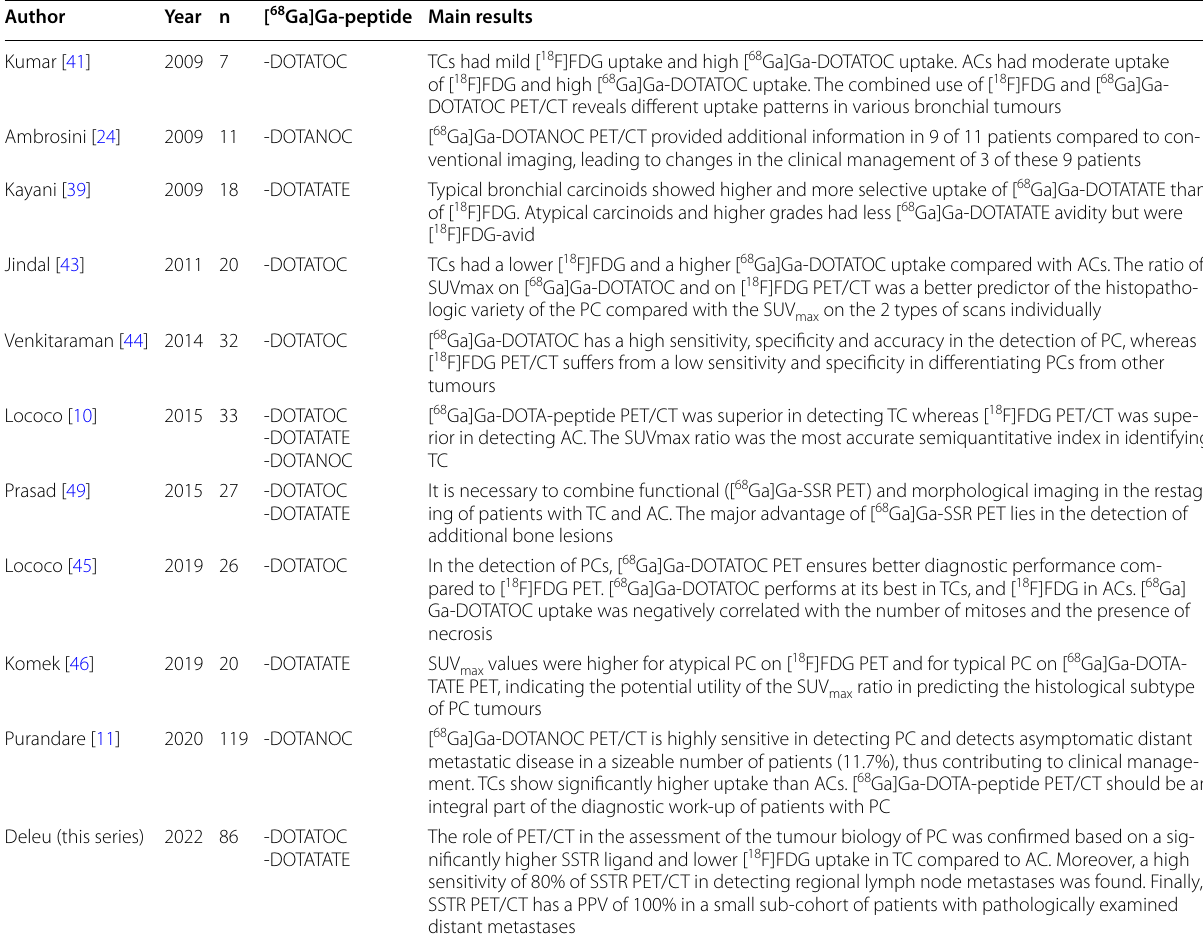
Table 4 Literature overview of [ 68 Ga]Ga‑peptide PET/CT in pulmonary carcinoid tumours (PCs) (case reports